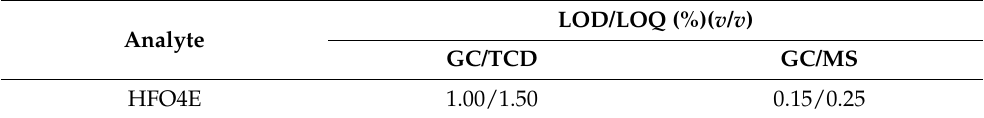
Table 2. LOD and LOQ for HFO4E obtained by GC/MS and GC/TCD. LOD/LOQ (%)( v / v ) Analyte GC/TCD GC/MS HFO4E 1.00/1.50 0.15/0.25